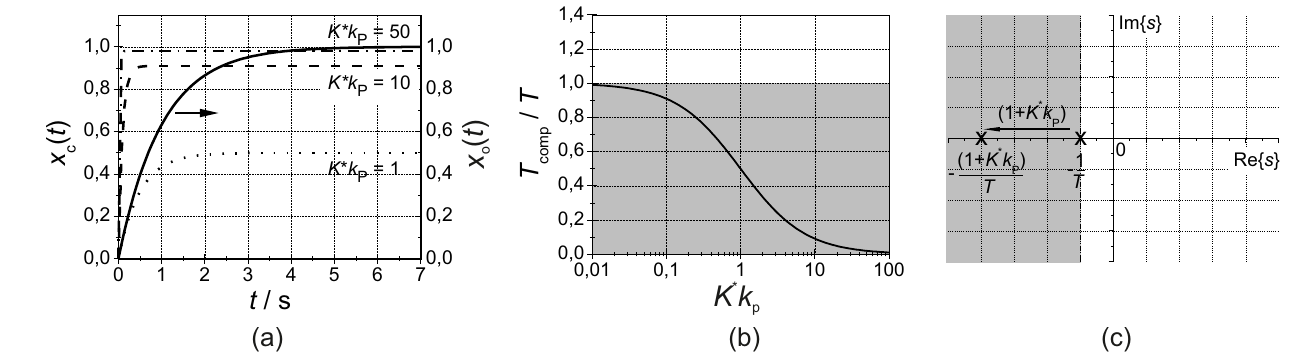
Figure 17. Influence of compensation method on (a) step response of an open-loop sensor (solid line) for T = 1s and a closed-loop sensor (interrupted lines) for di ff erent feedback factors; (b) normalized response time of a closed-loop sensor versus feedback factor; (c) schematic illustration of the pole-zero map indicating the pole shift due to the system’s feedback structure for compensation. The gray region indicates where a response time reduction is achieved.